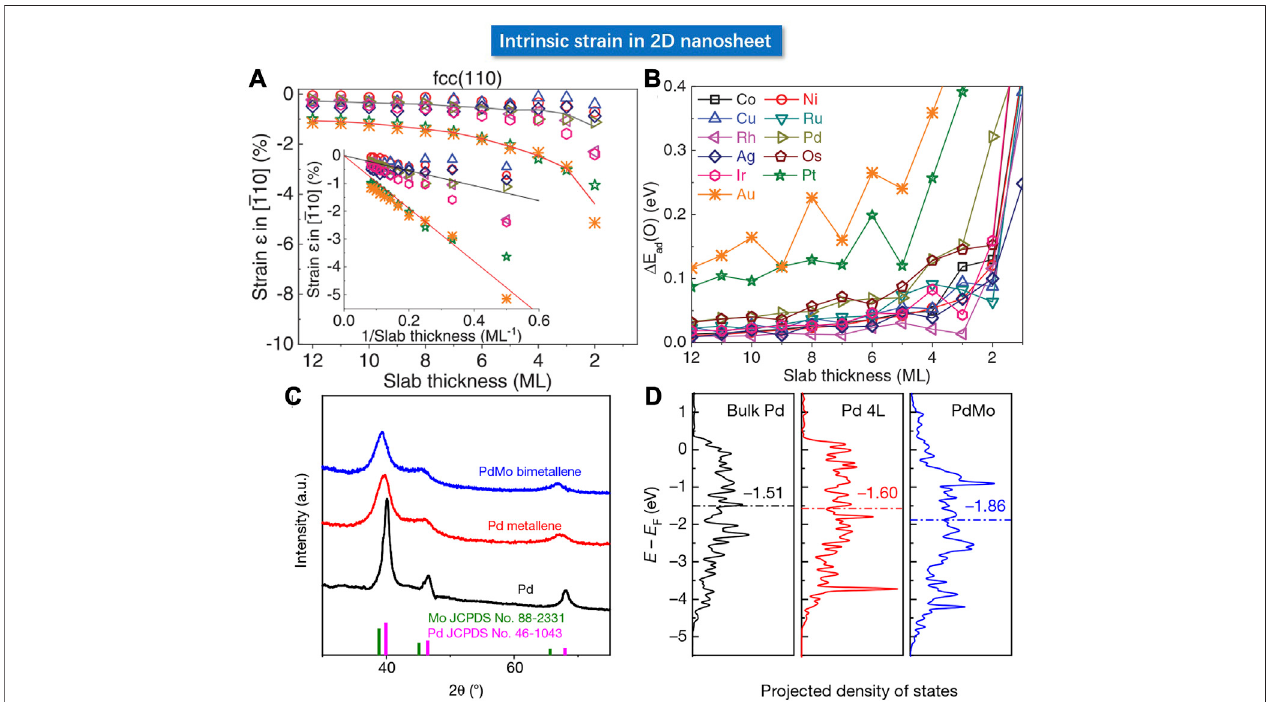
FIGURE13|(A) Therelationshipbetweenthestrainandthicknessofcoinmetalnanosheetsbycalculation.Theinsetshowsthatthemagnitudeofstrainisinversely proportional to the thickness. (B) Relationship between nanosheet thickness and O adsorption energy by DFT calculation. (C) Powder XRD patterns of PdMo bimetallene, Pd metallene and Pd. (D) Calculated d-band center of bulk Pd, Pd nanosheet (4L) and PdMo bimetallene. (A,B) Reproduced with permission (Wang et al., 2019a). Copyright 2019, American Association for the Advancement of Science. (C,D) Reproduced with permission (Luo et al., 2019). Copyright 2019, Springer